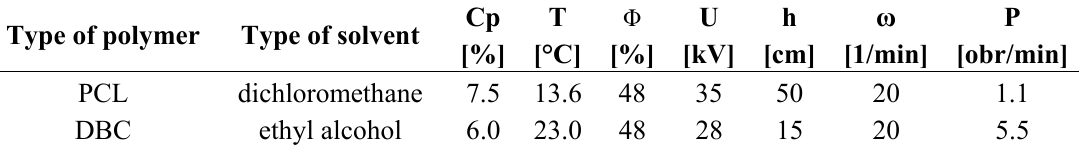
Table 3. Optimum conditions for formation of nonwoven fabrics from DBC and PCL fibres where: Cp = % concentration by weight; T = ambient temperature; Φ = air relative humidity; U = supply voltage; h = distance from to collector; ω = angular speed of collecting drum; P = angular speed of supply